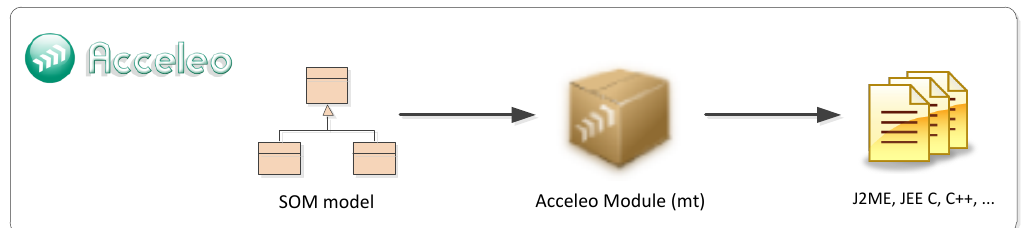
Figure 18. Code generation process using Acceleo.